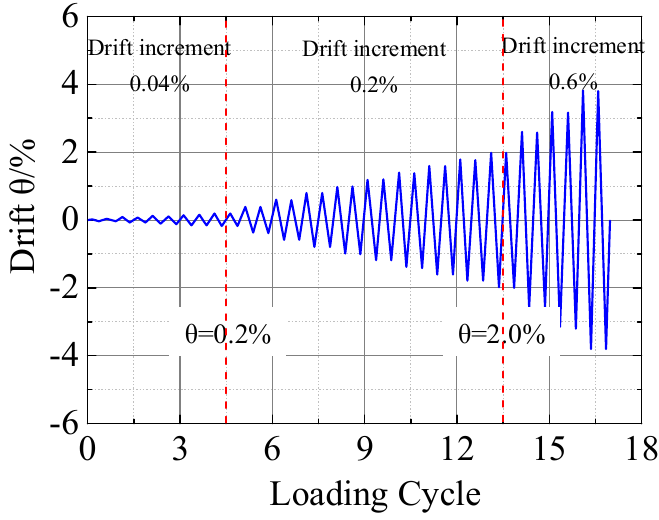
Figure 5. Loading Figure 5. Loading protocol.